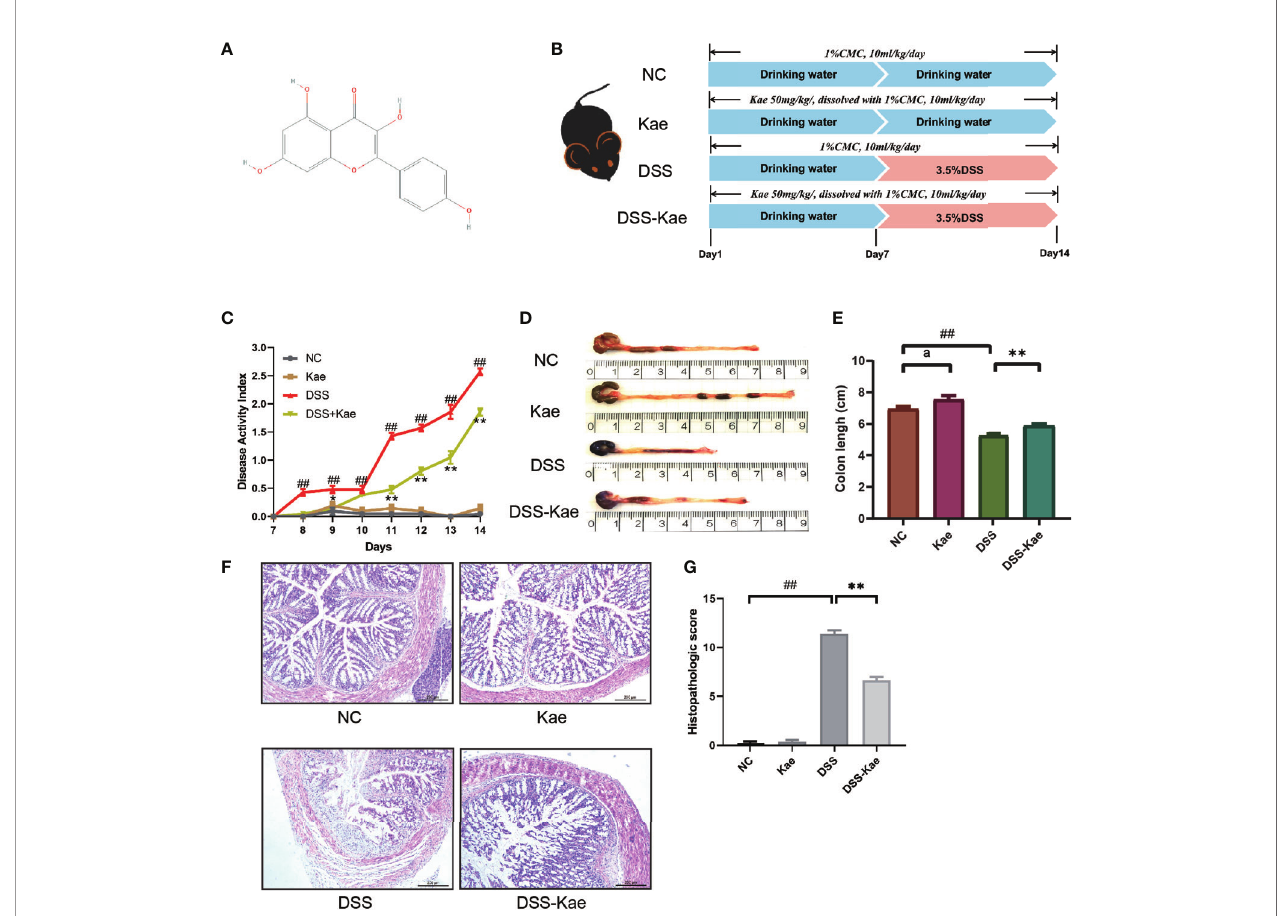
FIGURE 1 | Kae attenuates the symptoms of DSS-induced mice colitis. (A) Chemical structure of kaempferol (Kae). (B) Experimental design to test the effects of Kae on DSS-induced mice (n = 10/group). (C) Disease activity index of mice during the course of colitis. (D, E) Representative images of colons from mice following euthanization and statistical analysis of colon length in each group. (F, G) Representative images of HE stained colon tissue samples (scale bar, 200 m m) and histological scores of colonic tissues. Data are expressed as the mean ± SEM, n = 10, analyzed using one-way ANOVA with Tukey post-hoc analysis. DSS ( vs . NC, ## P < 0.01; vs . DSS-Kae, * P < 0.05, ** P < 0.01); Kae ( vs . NC, a P <